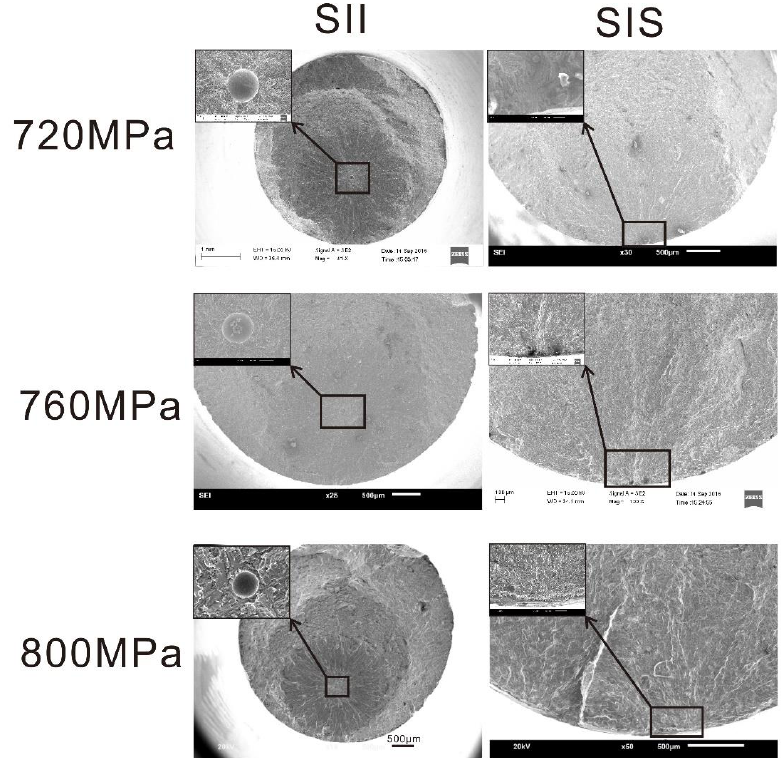
Figure 3. Typical fracture surfaces of specimens with internal crack initiation (SII) and specimens with crack initiating from suface (SIS) under three stress levels.